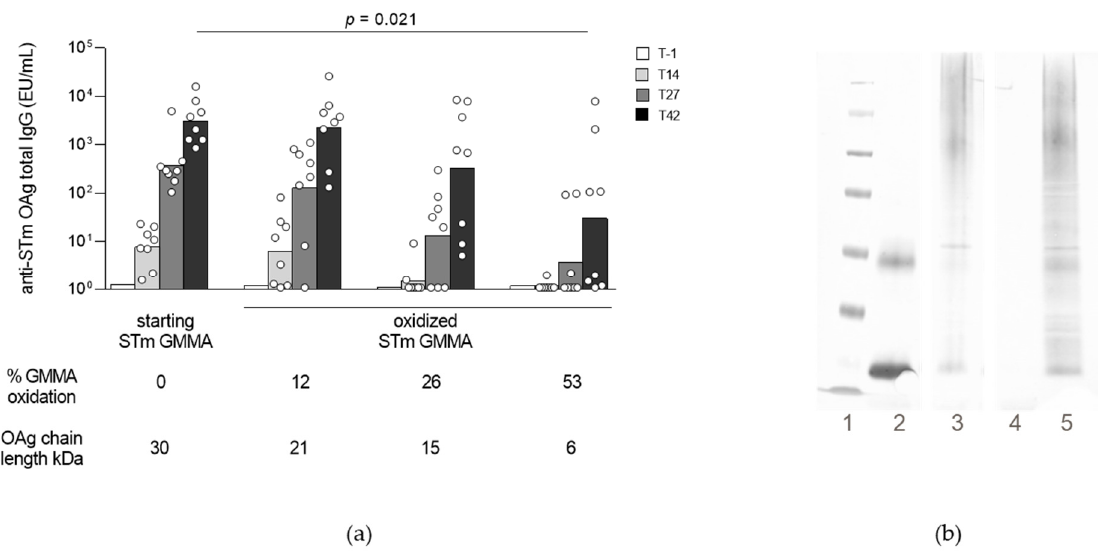
Figure 3. Impact of GMMA oxidation degree on GMMA immunogenicity in mice and conjugation efficiency. ( a ) Immunogenicity of oxidized STm GMMA compared to starting GMMA. CD1 mice were immunized subcutaneously at day 0 and 28 with 0.5 μ g mannose dose. All constructs were formulated in saline. Sera were analyzed at days − 1, 14, 27 and 42 by enzyme-linked immunosorbent assay (ELISA) using as coating antigen STm OAg. Summary graph of anti-antigen specific IgG geometric mean units (bars) and individual antibody levels (dots) is reported. ( b ) Characterization by WB analysis of the purified conjugates in comparison to corresponding unconjugated Pfs25. Ten μ g of conjugates and 2 μ g of protein were loaded per well. Lane 1: marker, lane 2: Pfs25, lane 3: conjugate with 26% oxidized GMMA, lane 4: